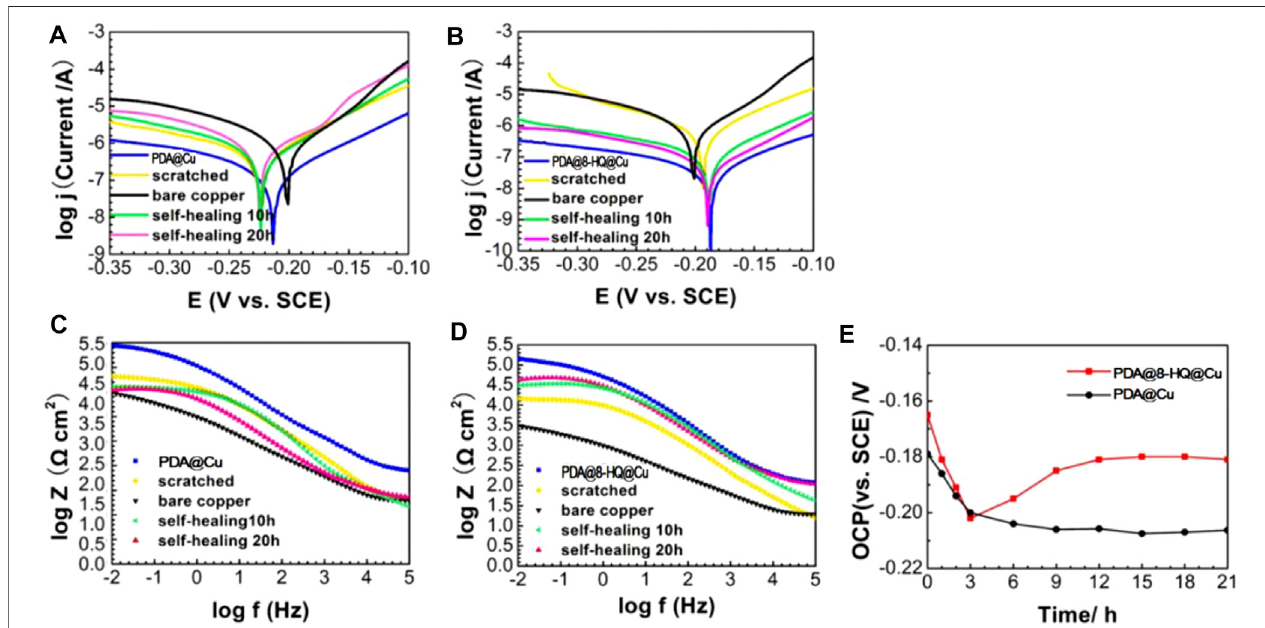
FIGURE 9 | Tafel (A,B) and Bode plots (C,D) recorded on the self-healing tests on scratched coatings of PDA@Cu and PDA@0.02M 8-HQ@Cu. (E) is OCP (vs. SCE) as a function of immersion time in 3.5 wt.% NaCl solution for scratched samples of PDA@Cu and PDA@0.02M 8-HQ@Cu.